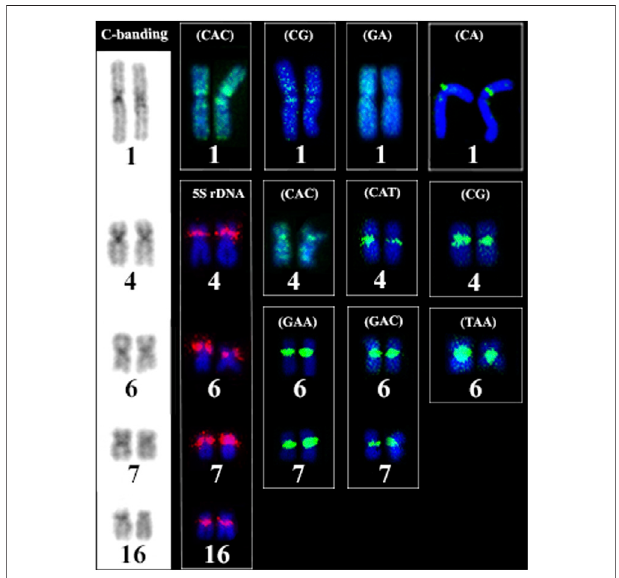
FIGURE 6 | Comparative analysis of the distribution of heterochromatic regions, 5S rDNA sites and microsatellite sequences and in the karyotype of Ancistrus sp. 2. Boxes indicate the repetitive sequences in heterochromatic regions of chromosome pairs 1, 4, 6, 7 and 16 of Ancistrus sp. 2. Chromosomes stained with Giemsa; hybridization signals with FITC (green) and Cy3 (red), chromosomes were counterstained with DAPI (blue).